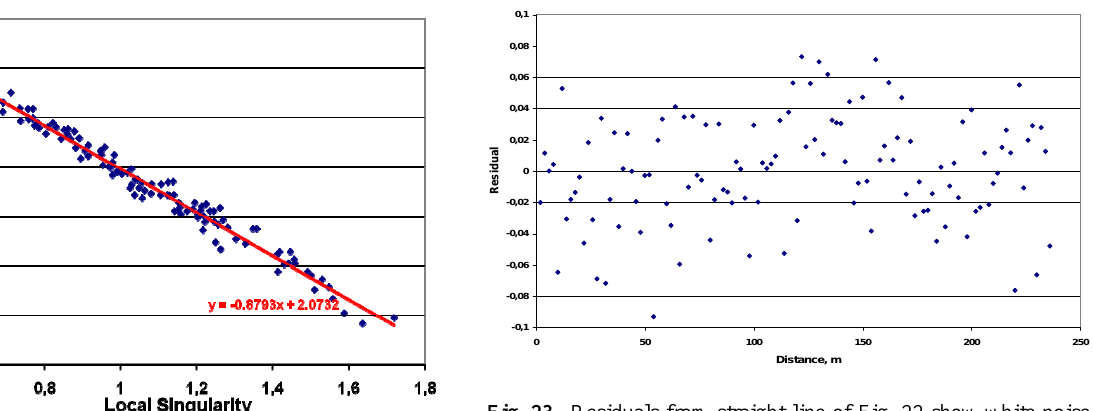
Fig. 23. Residuals from straight line of Fig. 22 show white noise pattern with variance equal to 0.00118.